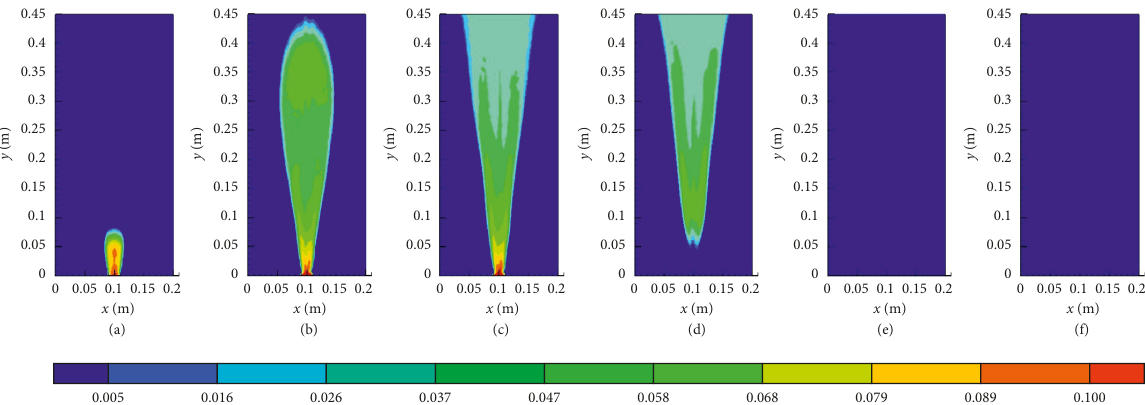
Figure 11: Instantaneous gas holdup distribution. (a) 160.2s, (b) 161.2s, (c) 162.2s, (d) 163.2 s, (e) 164.2s, and (f)